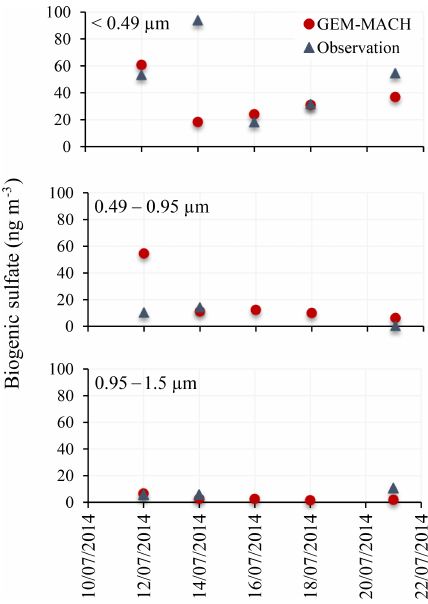
Figure 15. Measured and simulated 2d average biogenic fine sul- fate aerosol (0.49, 0.49–0.95 and 0.95–1.5µm) during July 2014.